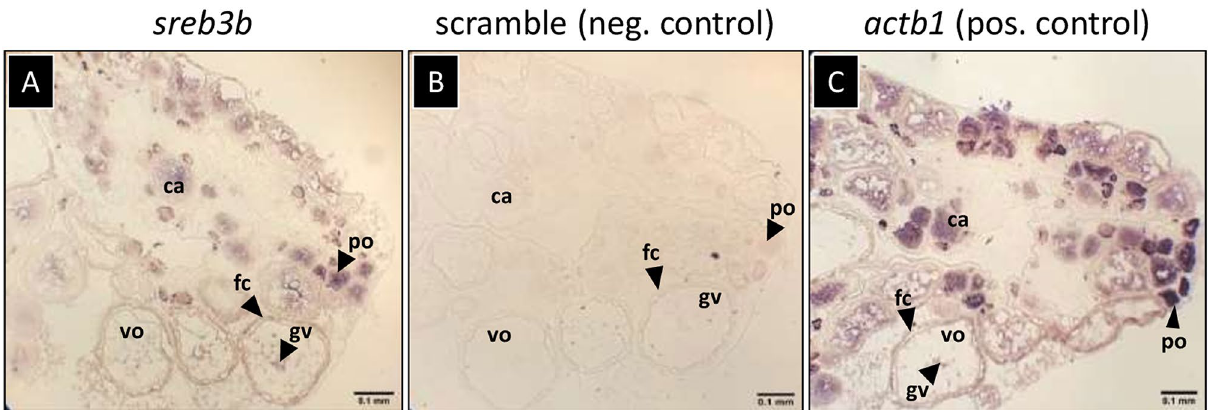
Figure 8. In situ hybridizations of ( A ) sreb3b , ( B ) scramble probe (negative control), and ( C ) actb1 (positive control) in the African turquoise killifish ( Nothobranchius furzeri ) ovary (n = 3). ca = cortical alveoli (secondary) oocyte, fc = follicle cell wall, gv = germinal vesicle, po = primary oocyte, and vo = vitellogenic